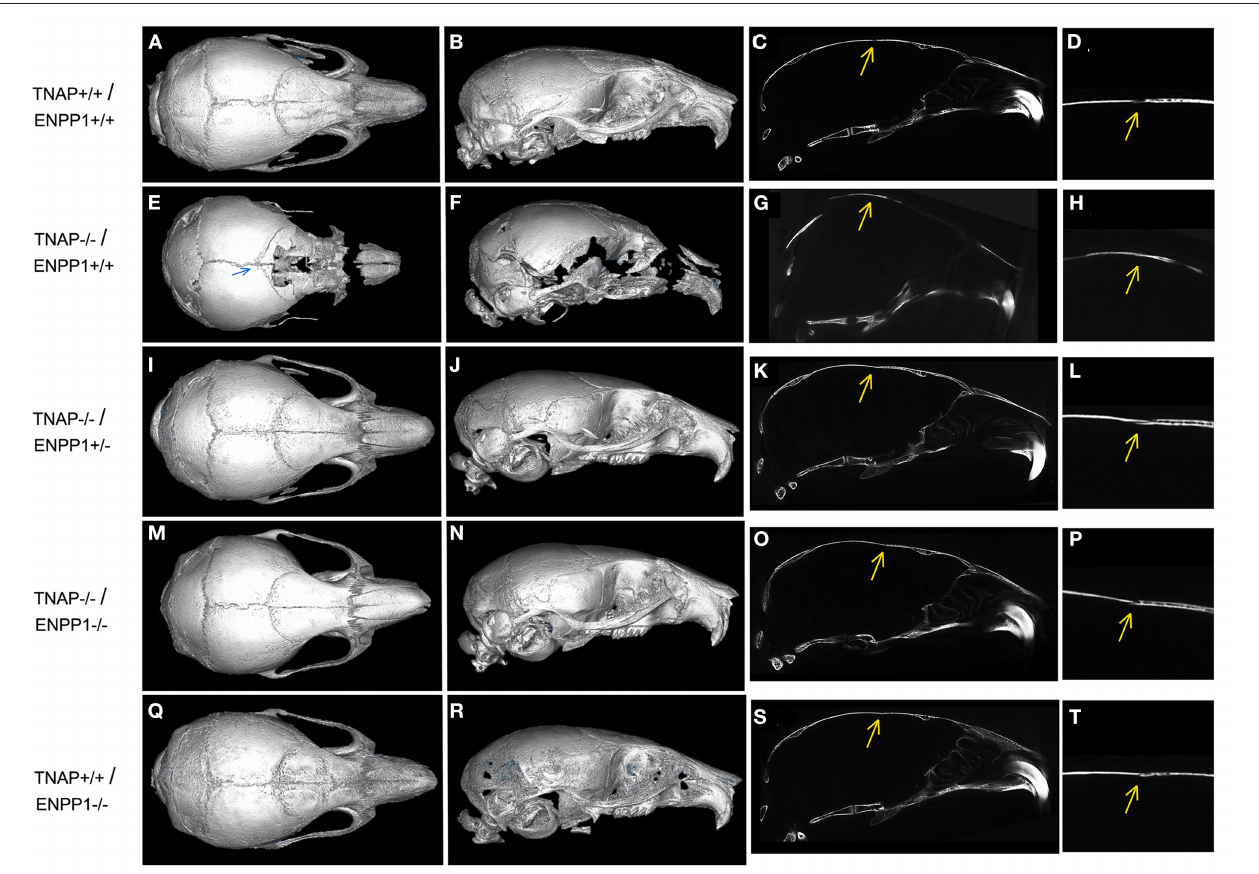
FIGURE 3 | Micro CT Isosurface Images of TNAP and/or ENPP1 mutant mouse skulls. Isosurface and 2D sagittal slice images including magnified image of coronal suture from micro-CT files of TNAP + / + /ENPP1 + / + mice (A–D) , TNAP − / − /ENPP1 + / + mice (E–H) , TNAP − / − /ENPP1 + / − mice (I–L) , TNAP − / − /ENPP1 − / − mice (M–P) and TNAP + / + /ENPP1 − / − mice (Q–T) are shown. Blue arrow indicates site of coronal suture fusion seen on isosurface image of TNAP − / − /ENPP1 + / + mouse. Yellow arrows indicate site of coronal suture with/without coronal suture fusion in 2D slice images of the mice. Fusion of the coronal suture is only seen in TNAP − / − /ENPP1 + / + mice (G,H) . Also note severe hypomineralization of cranial and facial bones in the severely affected TNAP null mouse. Double null mice appear more similar to wild type mice than the TNAP null